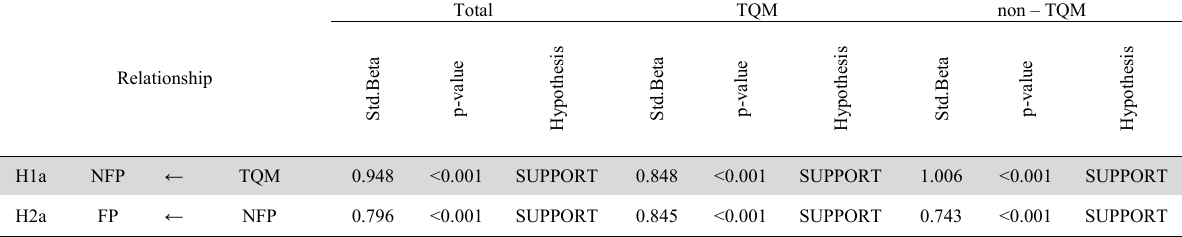
Hypothesis test for the mediating effect